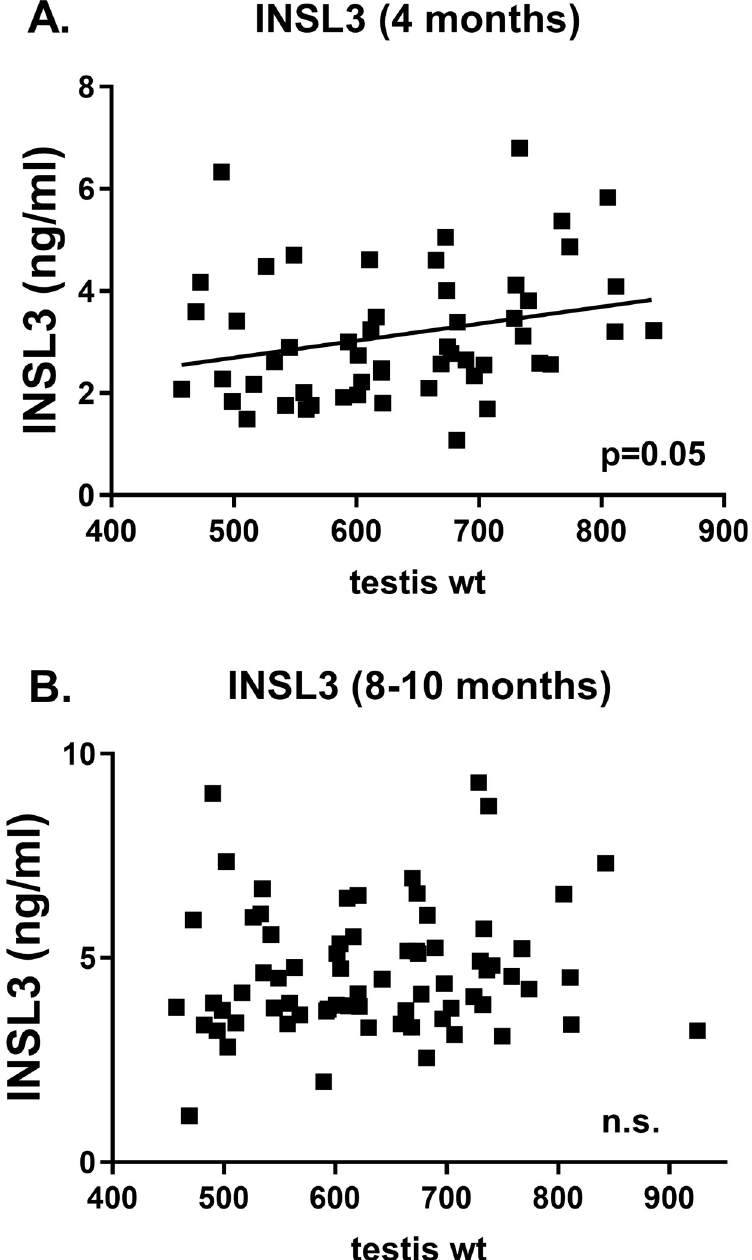
Fig 5. Regressions of paired testis weight at slaughter (18 months) against (A) INSL3 concentration at 4 months, and (B) average INSL3 concentration at 8–10 months . Probability of a significant regression is indicated as p value, or n.s. (not